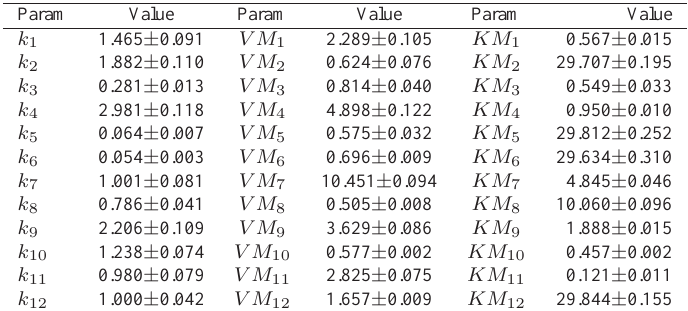
Table 2: Estimated parameter values for rat liver metabolites Param